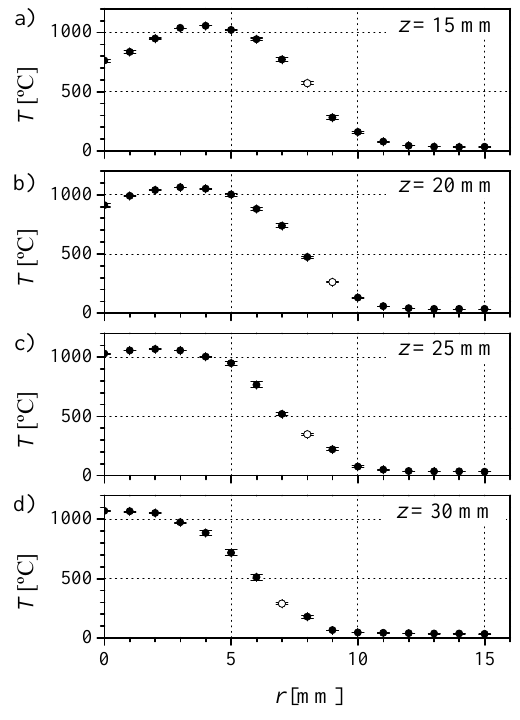
Figure 16. Measured temperature profiles at the flame at different distances to the Burner exit: ( a ) z = 15 mm, ( b ) z = 20 mm, ( c ) z = 25 mm, and ( d ) z = 30 mm. The white symbol corresponds to the limit of the visible